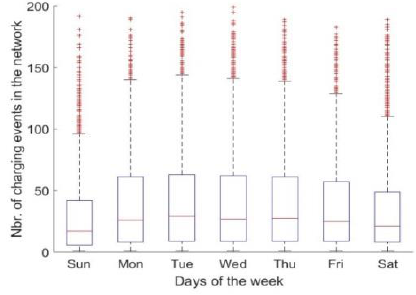
Figure 10. Boxplot of the average recharging events on the network per week day.